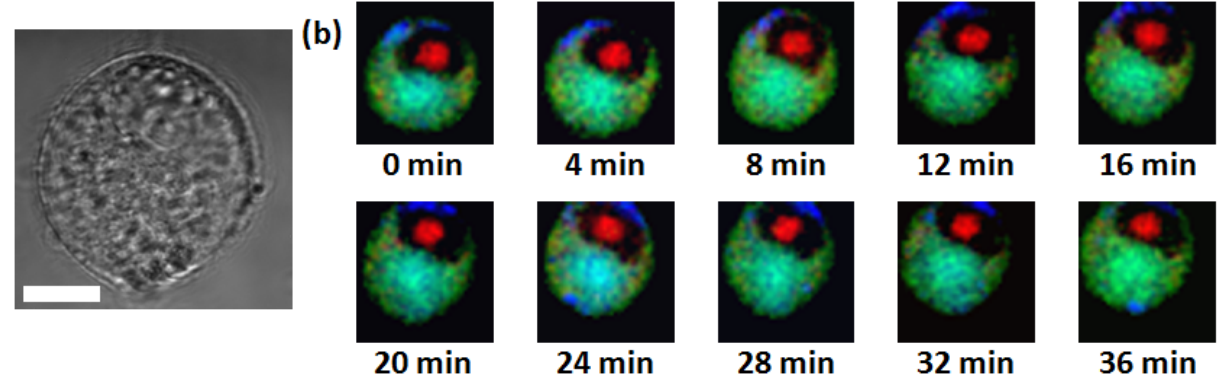
Figure 4. ( a ) Bright field image of live RKO cell used in the experiment. (Scale bar: 10 μ m) ( b ) Temporal Raman images of live RKO cell (40 × 40 pixels) with four ‐ minute temporal resolution. Red, green, and blue represent 785 cm − 1 , 720 cm − 1 , and 1450 cm − 1 Raman bands, respectively.